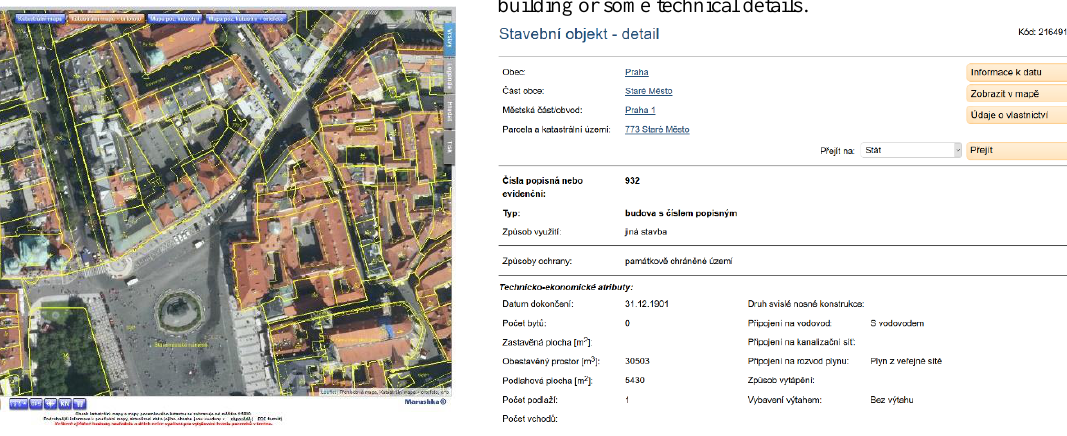
Figure 1. Cadastre map and orthophoto in web service by State Administration of Land Surveying and Cadastre. (ČÚZK, 2018)